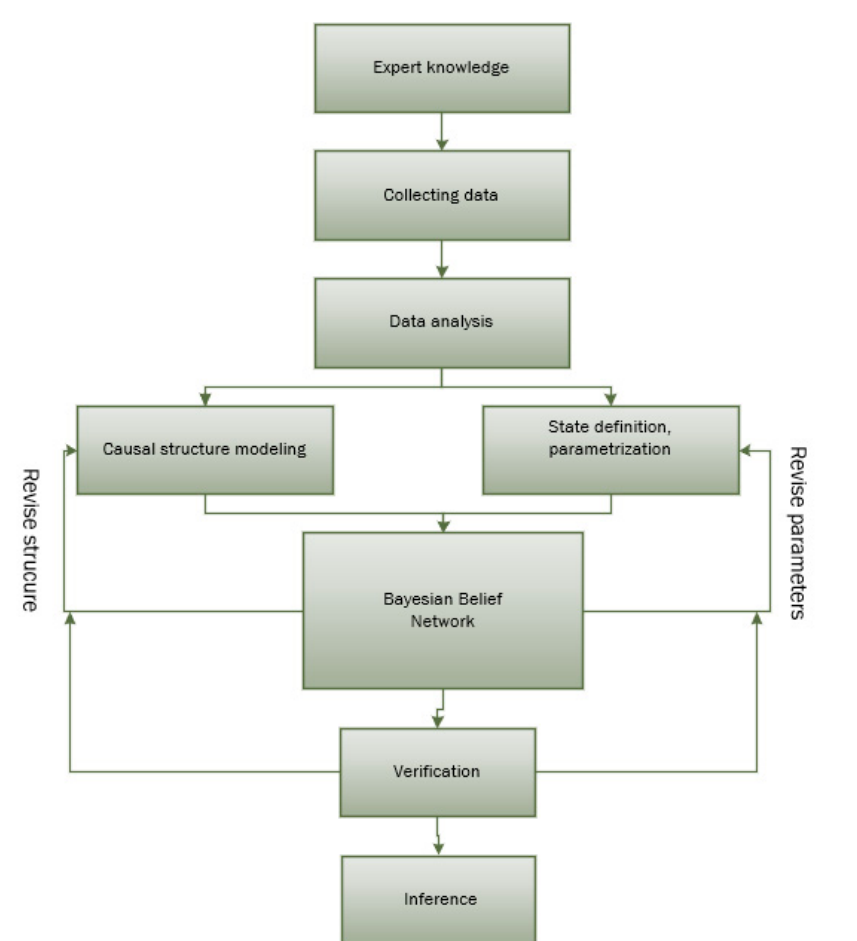
Figure 1. The BBN framework for maritime accident human error risk factor assessment. The mode values of the expert-assigned values were entered in the conditional prob- ability tables SMILE (structural modelling, interface, and learning engine) and GeNie GUI (graphical network interface) to create and quantify the Bayesian network [20].